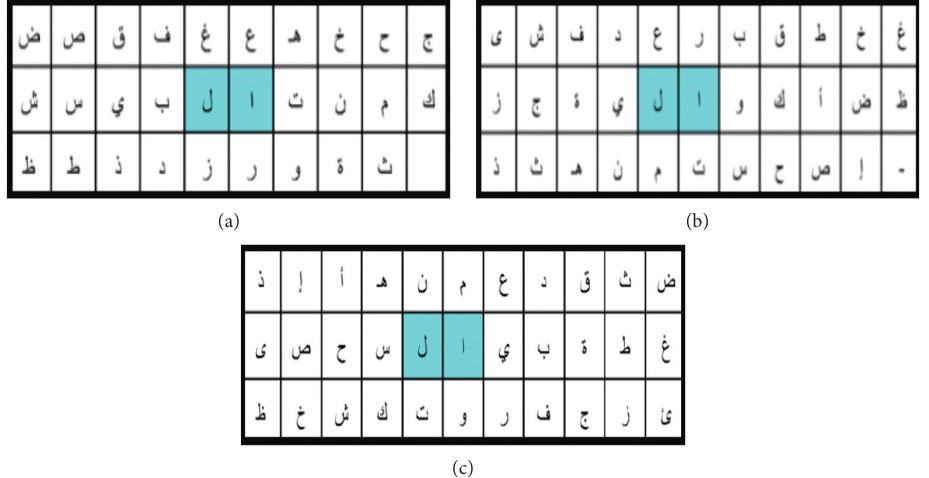
Figure 8: Keyboard layouts used in the experiments: (a) commonly used layout; (b) optimized layout by the SA; (c) optimized layout by the GA in [8].